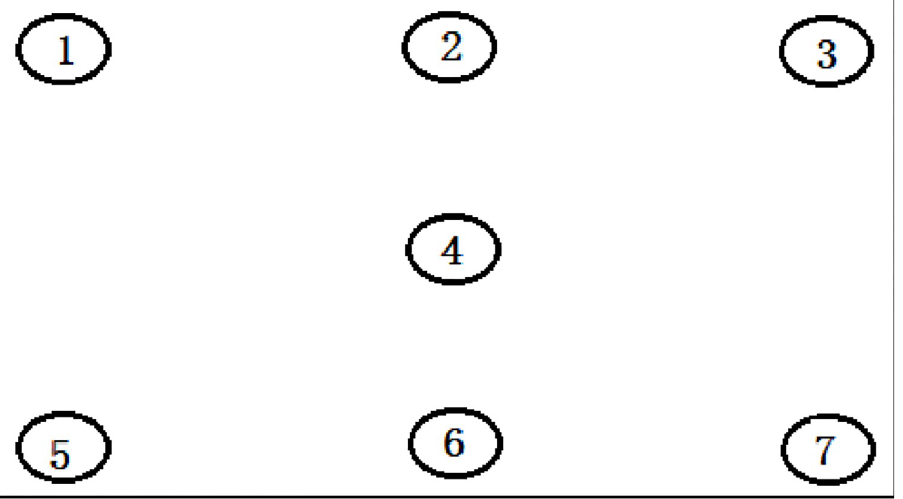
Fig 3. Sampling plan for mushroom